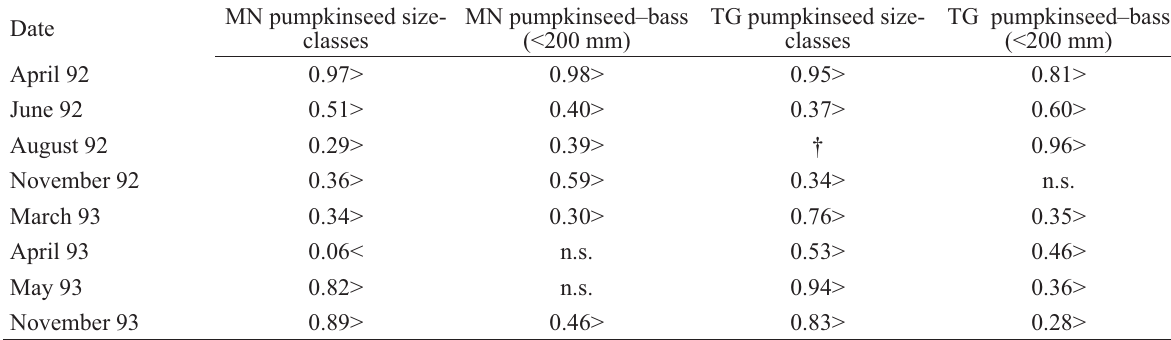
Piankas’s index of overlap for size-classes of largemouth bass, Micropterus salmoides and the pumpkinseed, Lepomis gibbosus sampled in Monte Novo and Tapada Grande reservoirs, Iberian Peninsula